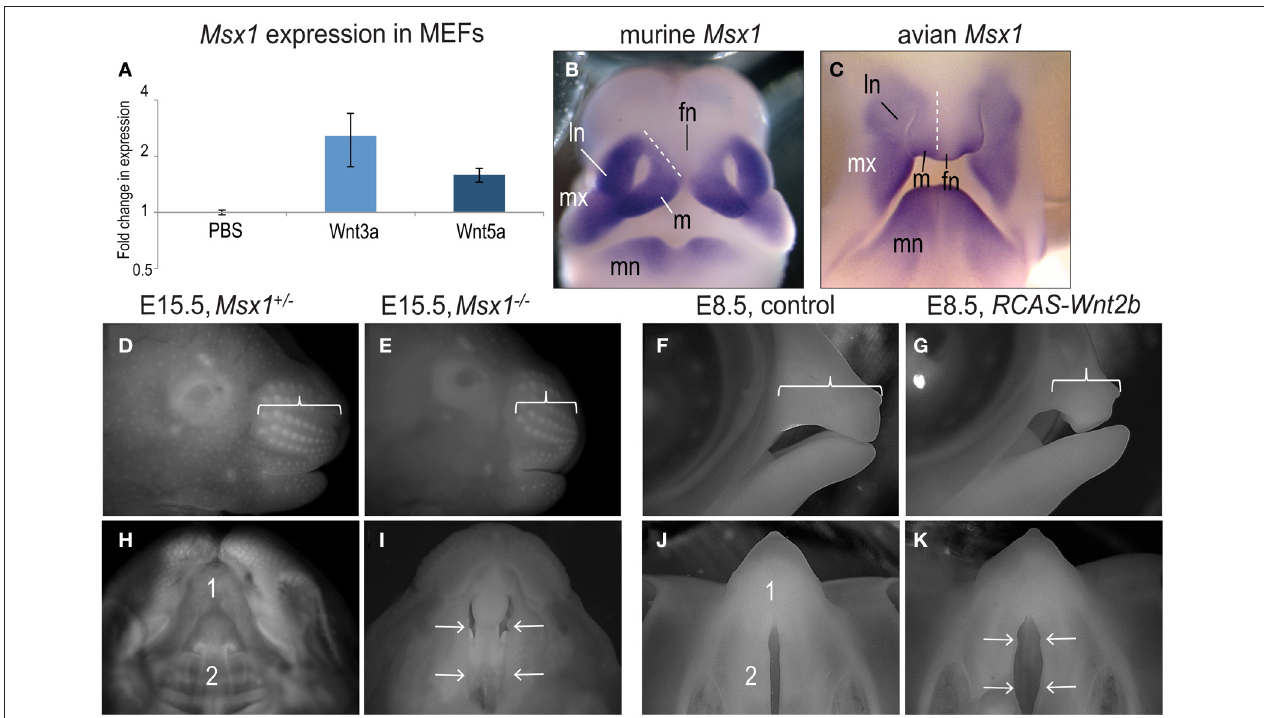
secondary (2) palates are fused in Msx1 + / − embryos but the secondary palate is cleft in Msx1 − / − embryos (arrows). (J) Ventral view of control and (K) RCAS:Wnt2b treated E8.5 chicken embryos. Primary (1) palate is fused while secondary (2) palate is naturally cleft in control embryos; note widening of secondary palate secondary to ectopic Msx1 expression (arrows). fn, frontonasal prominence; ln, lateral nasal prominence; m, medial nasal prominence; mn, mandibular prominence; mx, maxillary